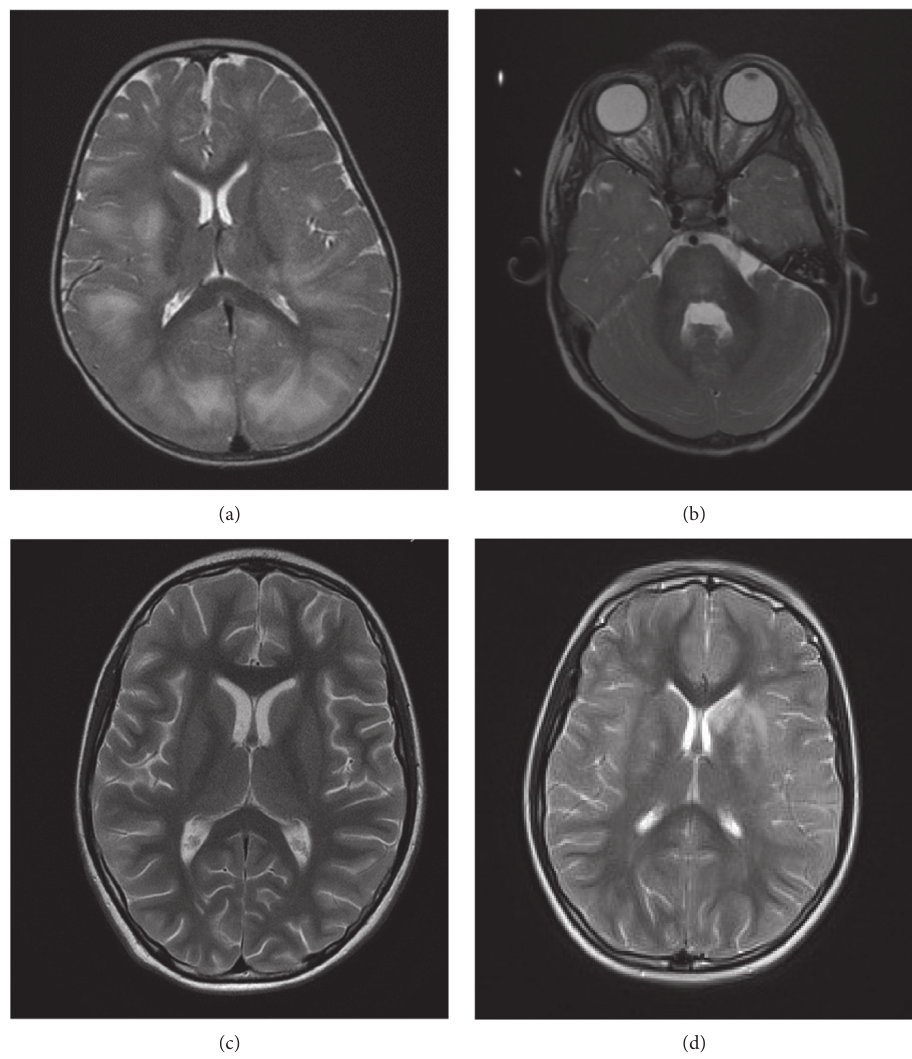
Figure 1: (a, b) MRI brain of Case 1 showing bilateral T2 hyperintensities of the subcortical white matter of all the brain and splenium of the corpus callosum with associated diffusion restriction and signal change in thalami and pons. (c) Case 2: normal MRI brain on acute presentation. (d) Repeat MRI brain 50 days later showing bilateral T2 hyperintensity of the basal ganglia and parasagittal frontal lobes, anterior limb of the left internal capsule, insula, and subcortical white matter